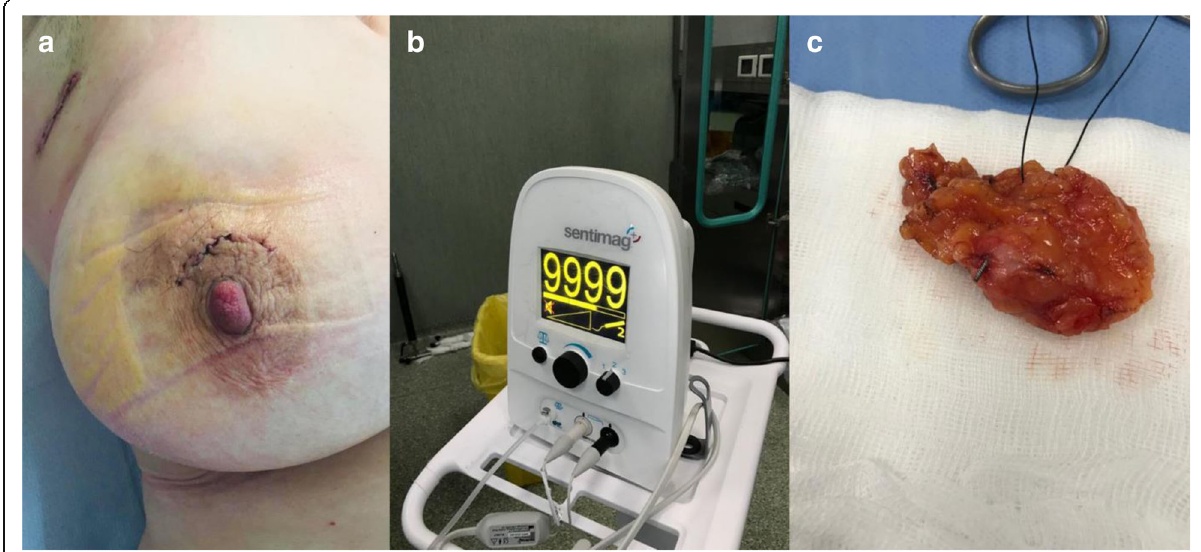
Fig. 2 Small periareolar incision performed with preoperative lesion localisation using Magseed® and Sentimag® ( a ). Monitor showing magnetic field ( b ). Specimen containing Magseed® ( c